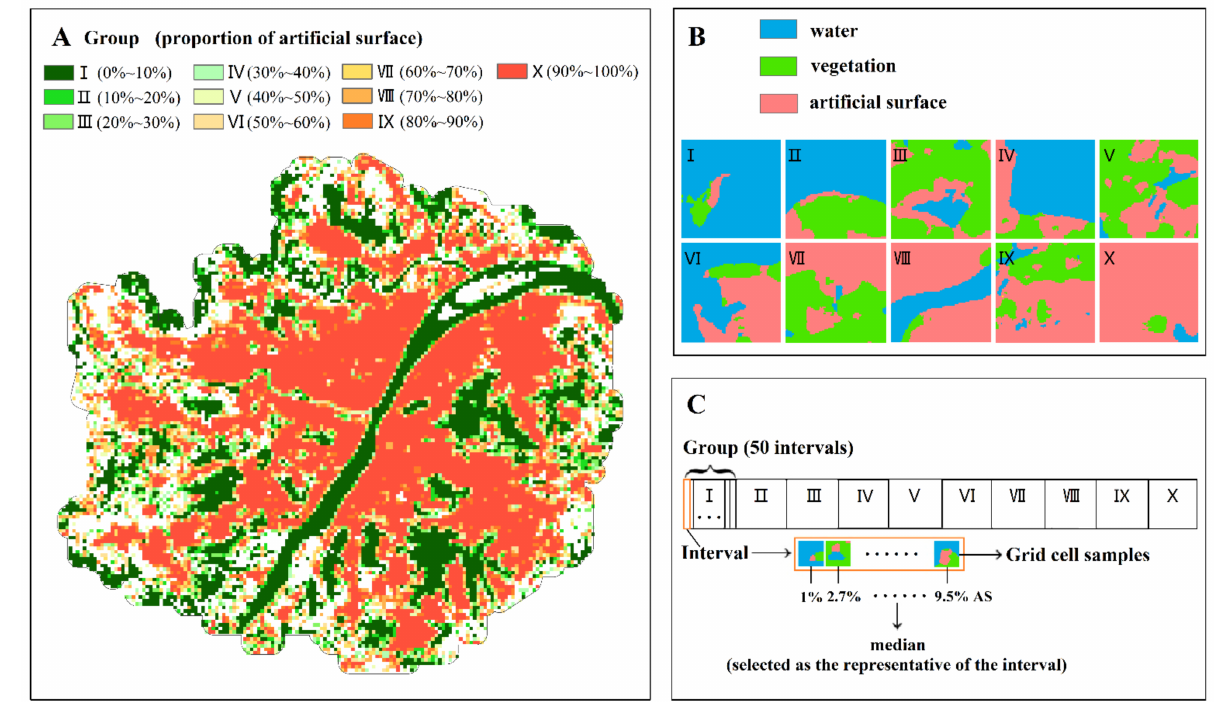
Figure 3. Wuhan grid cell sample grouping results: ( A ) Samples of all grid cells. ( B ) Grid cell samples exclusively chosen for Group I to Group X. ( C ) Graphical interpretation of samples of groups, intervals, and grid